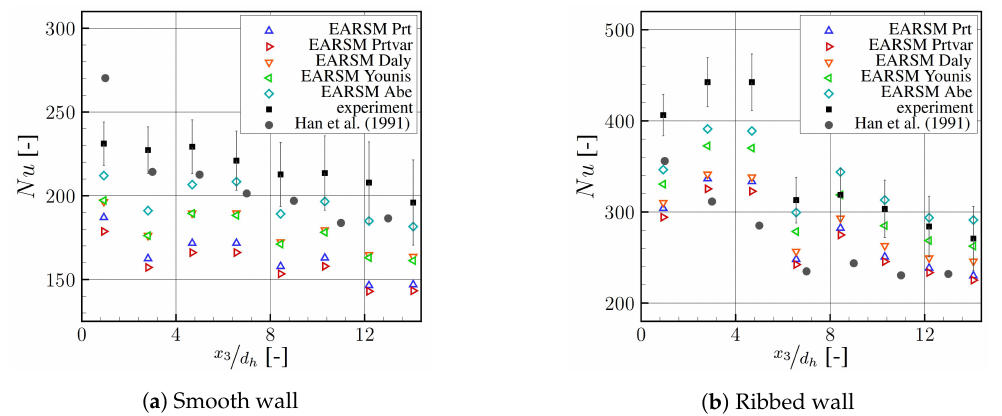
Figure 8. Averaged Nusselt numbers over normalized length, experimental data, different turbulent heat flux